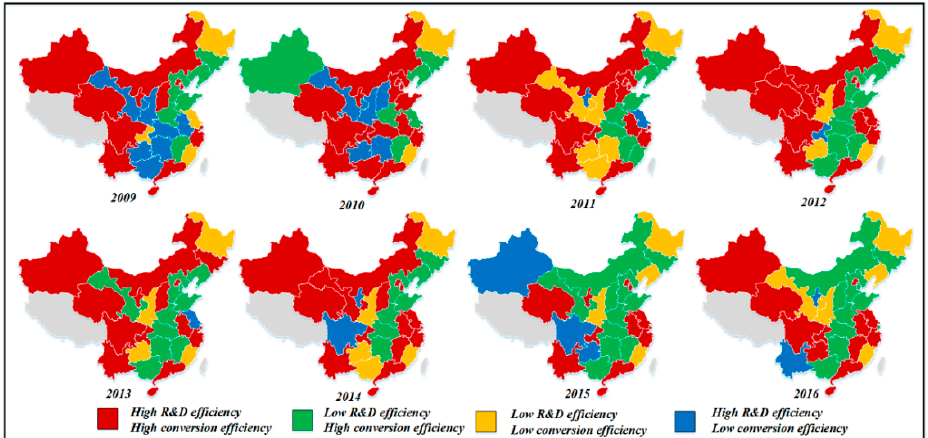
Figure 11. The evolution map of the classification of industrial enterprises’ green innovation in China (2009 – 2016).